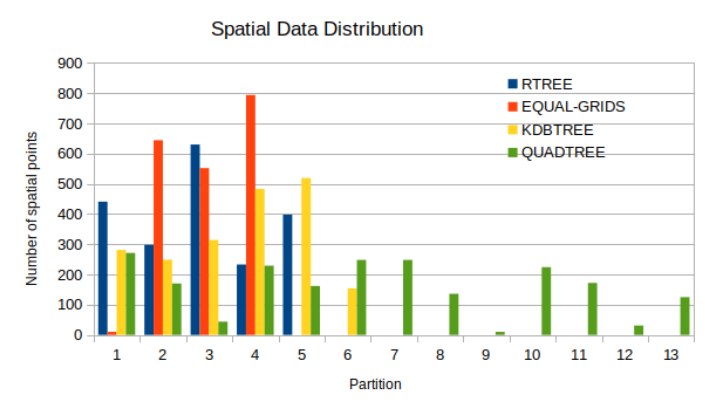
Figure 8. Spatial PointRDD Data Distribution for 4 Spatial Partition Techniques for 2000 Mobile